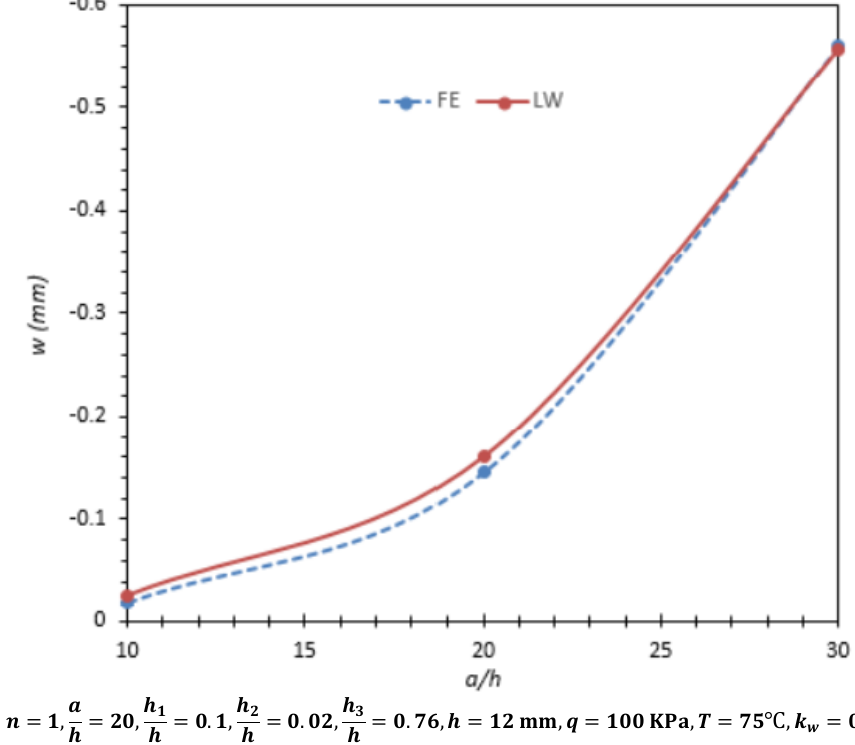
Figure 9. Effect of the variation of a/h on the center deflection of sandwich plate.